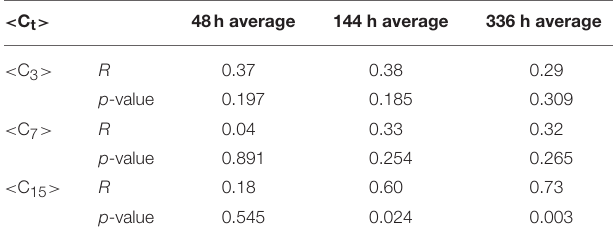
TABLE 3 | Correlations obtained by using mean values < C t > of model concentrations.